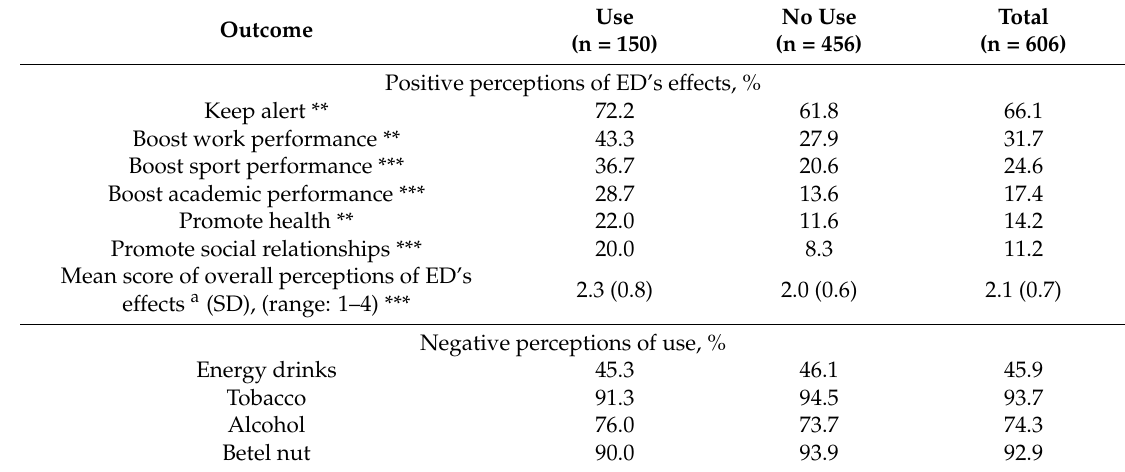
Table 3. Attitudes toward using energy drinks and other substances, by energy drink use in the past 30 days.